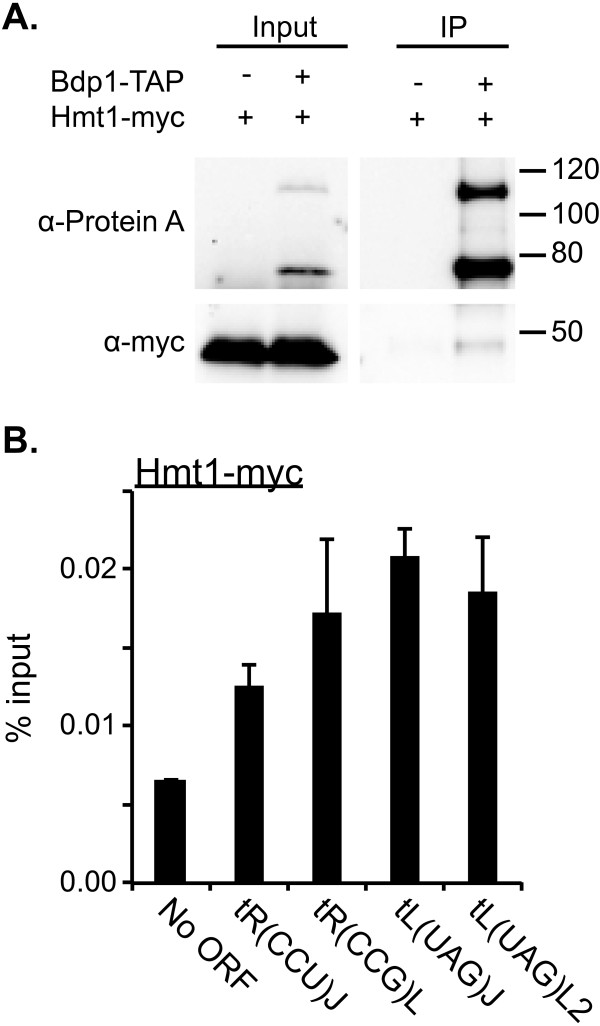
Hmt1 physically associates with TFIIIB component Bdp1. A) Affinity purification of Bdp1-TAP results in the co-purification of Hmt1-myc, as shown by immunoblotting with α-myc (for Hmt1) and α-Protein A (for Bdp1). B) Directed ChIP shows Hmt1 binding on tDNAs tR(CCU)J, tR(CCG)L, tL(UAG)J, tL(UAG)L2. ChIP signals were normalized to “No ORF”, which is an intergenic region on the right arm of Chromosome IV [68].